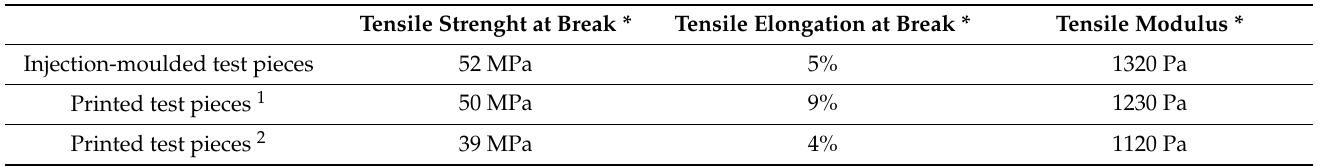
Table 1. Technical specifications of the PLA used. Adapted from: BQ, “PLA Filament 1.75 mm” Technical